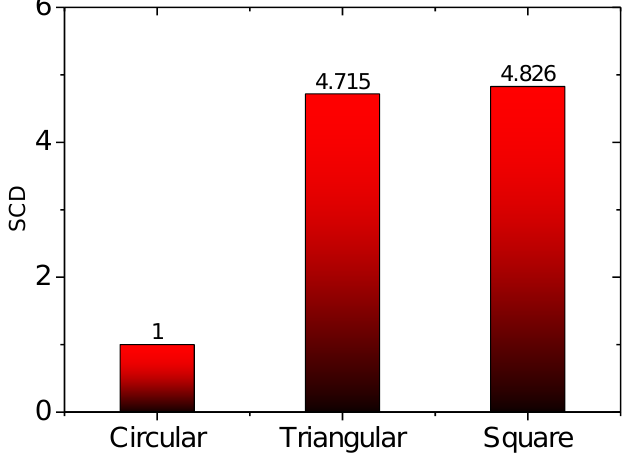
Figure 9. Saturated Correlation Dimension (SCD) of pressure signal time series in di ff erent flow fields.